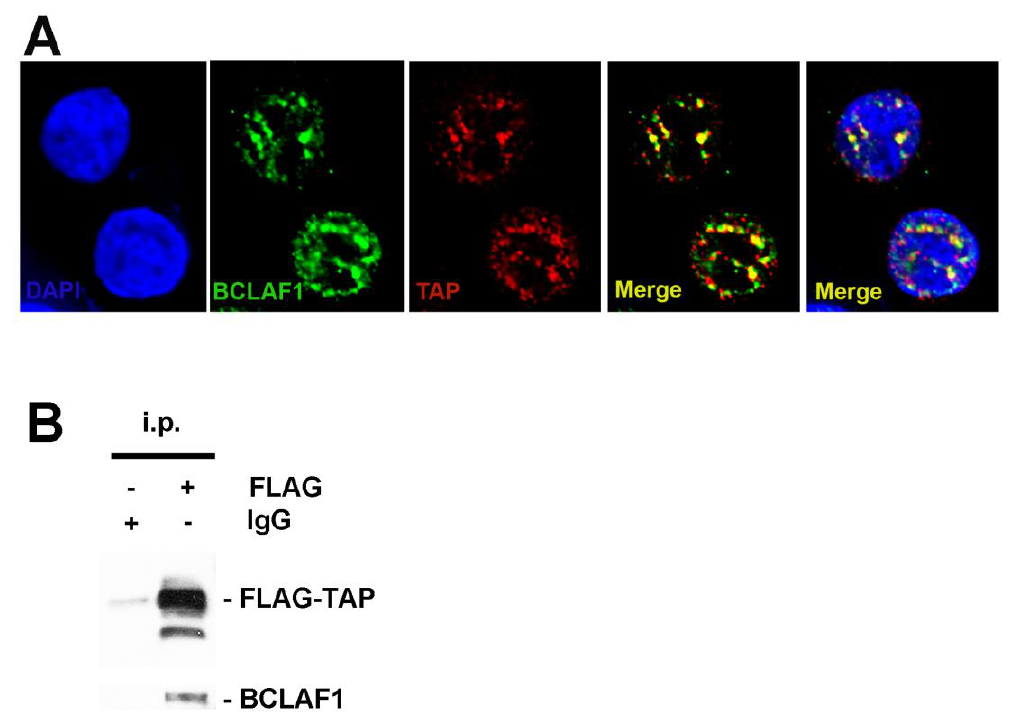
FIGURE 3. BCLAF1 interaction with TAP. (A) Indirect immunofluorescence staining of BCLAF1 and TAP. Representative micrograph showing DAPI-stained nucleus of HeLa cells (blue, DAPI) stained with anti-BCLAF1 (green, BCLAF1), and anti-TAP (red, TAP). Merged images show colocalization of endogenous BCLAF1 and TAP (Merge, yellow). (B) Coimmunoprecipitation of BCLAF1 with TAP. Protein lysate from HeLa cells transfected with FLAG-TAP was incubated with either control IgG or anti-FLAG. Western analysis of immunoprecipitated complexes was performed with anti-FLAG, followed by